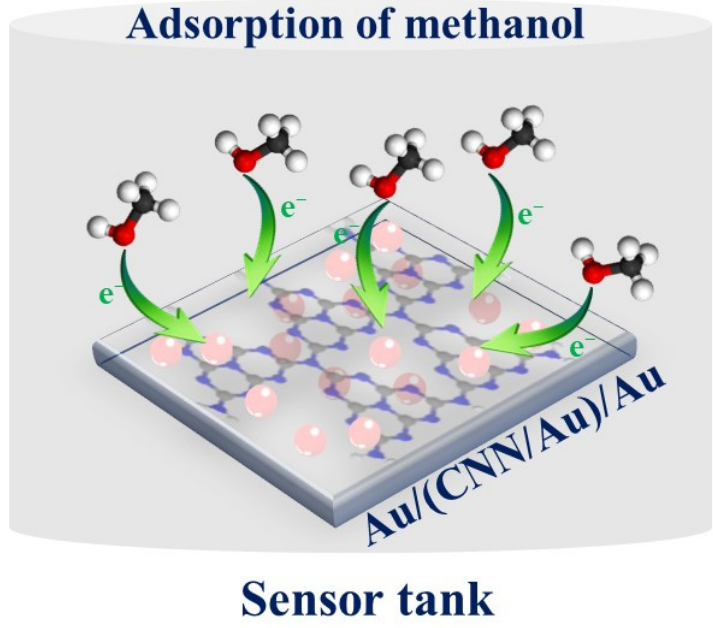
Figure 8. Schematic presentation of the methanol-sensing mechanism.